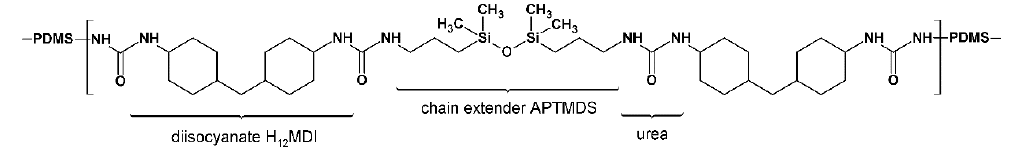
Figure 2. An average HS repeating unit. Example shown is that for the PSU elastomer based on H 12 MDI with an HS content of 5%. In this elastomer, the molar ratio of PDMS:NCO:APTMDS is approximately 1:2:1, represented in the structure by the PDMS followed by the HS repeating unit (within brackets) consisting of two diisocyanate molecules and one chain extender molecule. For reasons of simplification, the propyl-chains between the PDMS and urea groups are omitted from this structure.